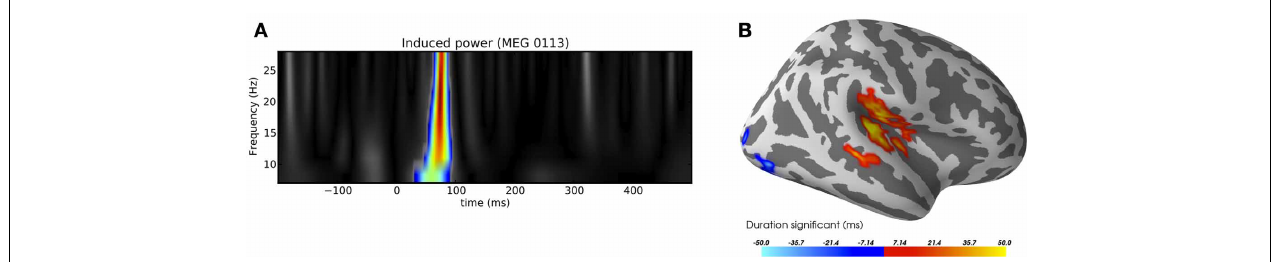
FIGURE 7 | Examples of clustering. (A) Time-frequency clustering showing a significant region of activation following an auditory stimulus. (B) A visualization of the significant spatio-temporal activations in a contrast